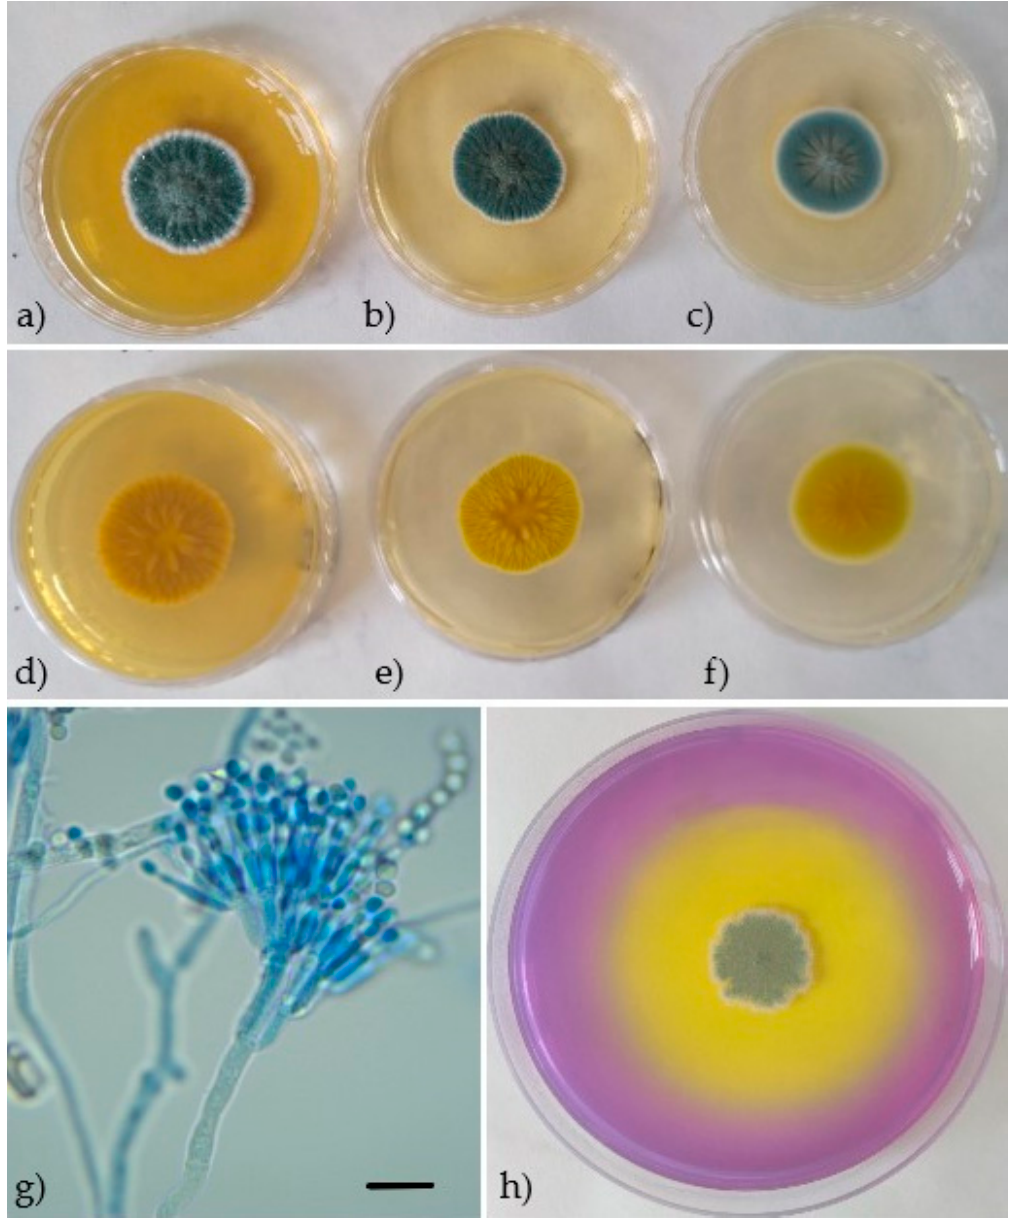
Figure 2. Penicillium commune . Seven-day-old colonies on Malt Extract Agar (MEA) ( a ) obverse, ( d ) reverse, Czapek Yeast Autolysate agar (CYA) ( b ) obverse, ( e ) reverse, Yeast Extract Sucrose agar (YES) ( c ) obverse, ( f ) reverse, ( h ) Creatine Sucrose Agar (CREA)—strong acid production, ( g ) conidiophores and conidia. Scale: black bar = 10 μ m. Identified P. crustosum strains also showed good growth on MEA, CYA, and YES media. The average colony diameters were (34.10 ± 4.05) mm for MEA (34.33 ± 4.50) mm for CYA and (34.76 ± 4.90) mm for YES agar after incubation at 25 °C for 7 days. Colonies on both MEA and CYA were weakly fasciculate to crustose, dull green to grey green with corrugation and thin white edge hem. Reverse colony color on MEA was cream to beige. On CYA, copious clear or brown exudate droplets were present and reverse colony color was cream to yellow brown. Characteristic crustose colonies of grey green color with thin white edge hem and cream to yellow reverse were observed on YES medium. Conidio- phores were terverticillate with rough-walled stripe, phialides cylindrical tapering to a distinct collulum. Conidia were smooth-walled, globose to subglobose. Negative Ehrlich